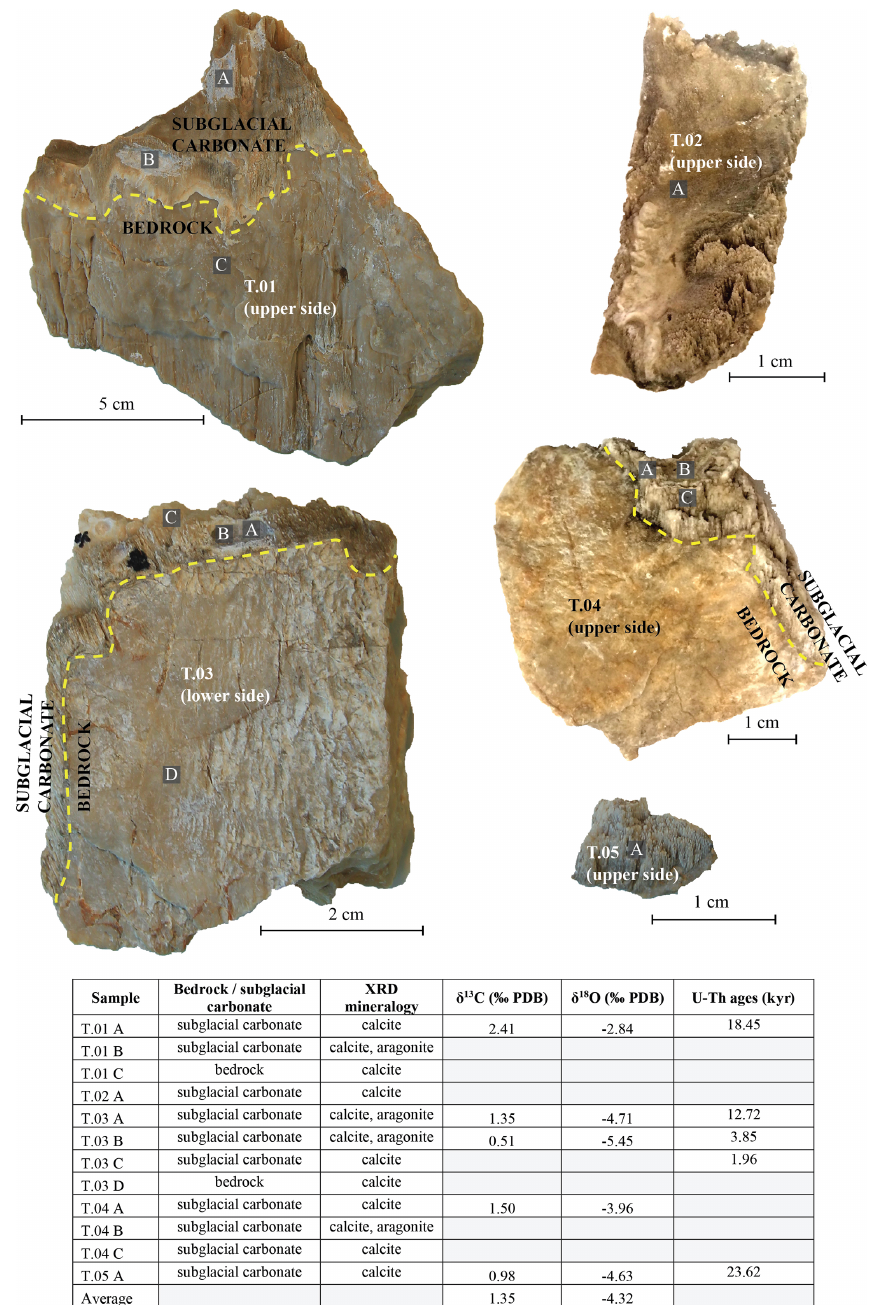
Figure 3. Subglacial carbonate samples used for this study. Upper and lower sides refer to the surface (facing open air before being collected) and underside of the carbonate samples, respectively. The depths were measured relative to the drilling starting point of each sample as they are shown in this figure (lower-side perspective for sample T.03 and upper-side perspective for all the other samples); only the T.03 sample had precipitates thick enough to allow us to obtain several dates at three different